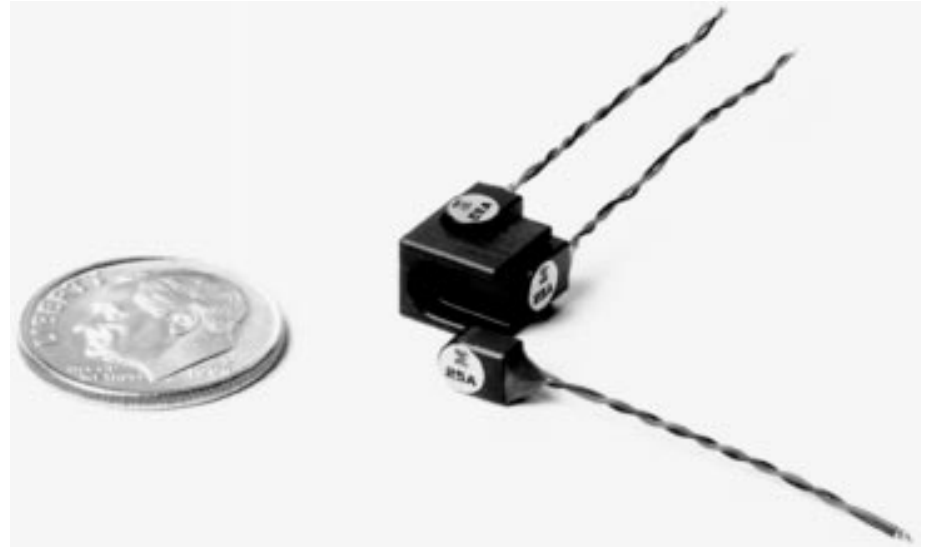
Fig. 5b. The smallest triaxial piezoelectric accelerometer with integral electronics (Endevco, about